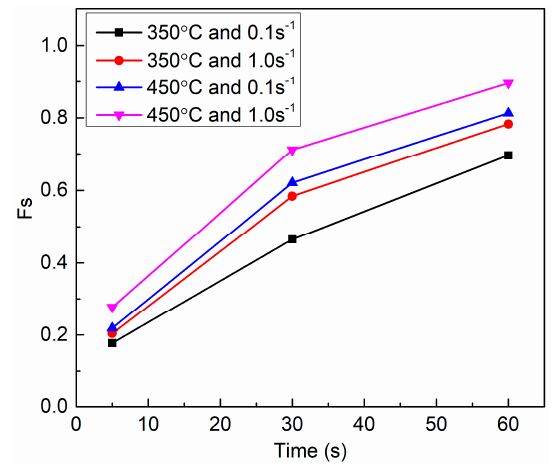
Figure 4. The contrast of the static softening fraction at different strain rates and deformation temperatures.